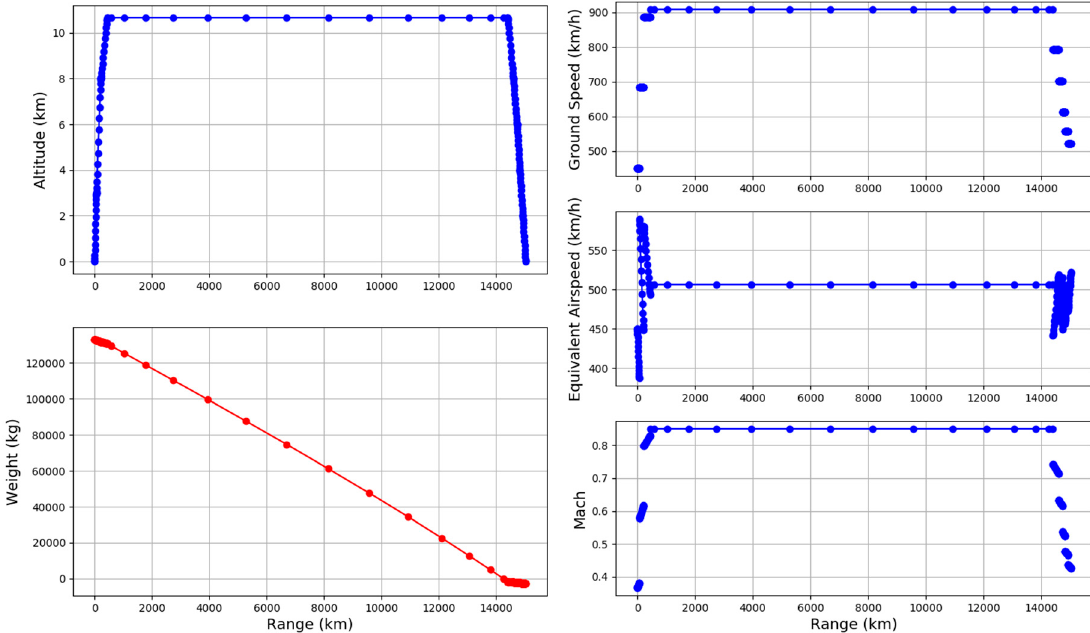
Figure A8. Mission performance of SE²A-LR.